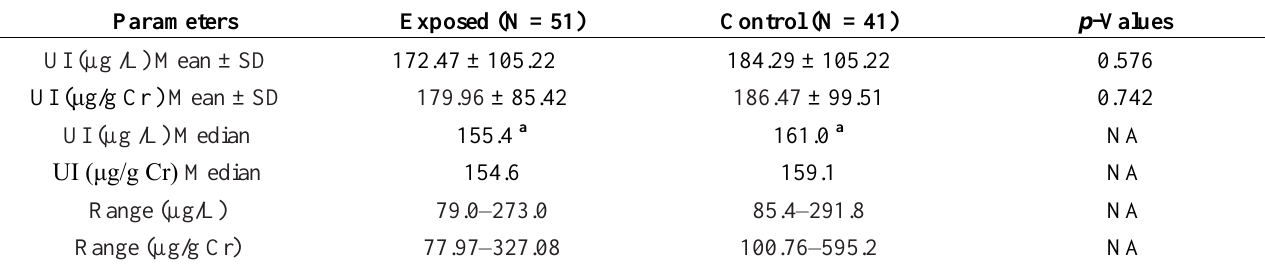
Table 7. Mean and median values of urinary iodine (UI) concentrations of each group (unadjusted and adjusted by creatinine).